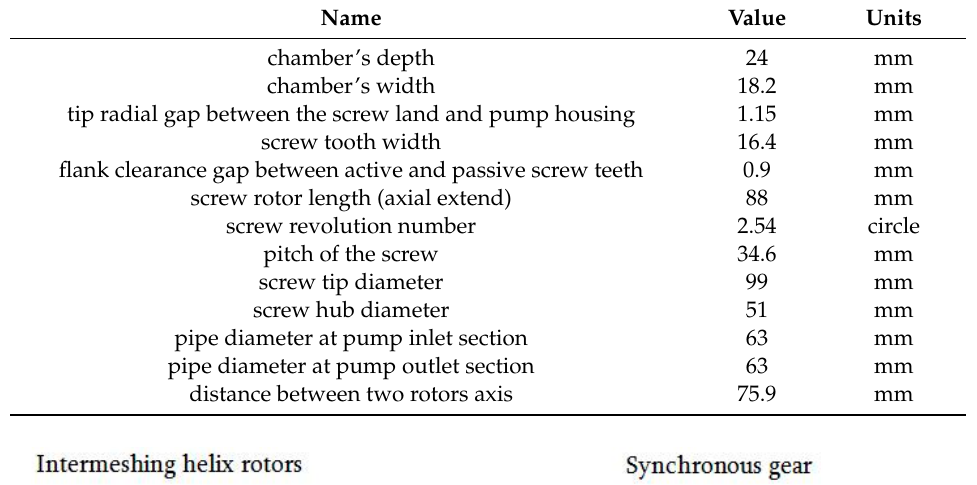
Table 1. The pump’s main dimensions.